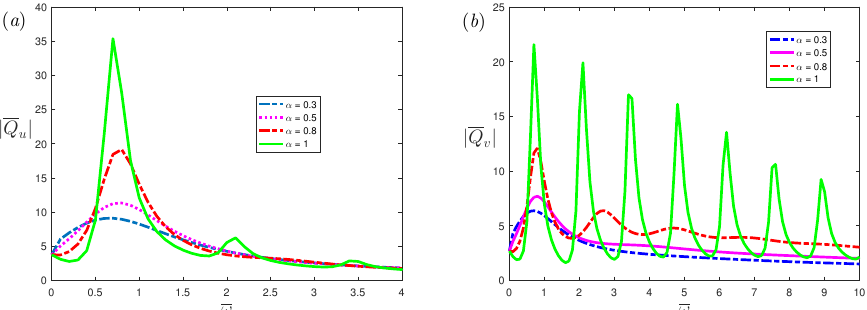
Figure 8. The dimensionless mean volumetricflow rate, ( a ) spanwise; ( b ) streamwise, of fractional Maxwell model with the dimensionless frequency ω for different fractional parameters α at β = 1, K = 20, L = 0.03, De = 5, Ha =